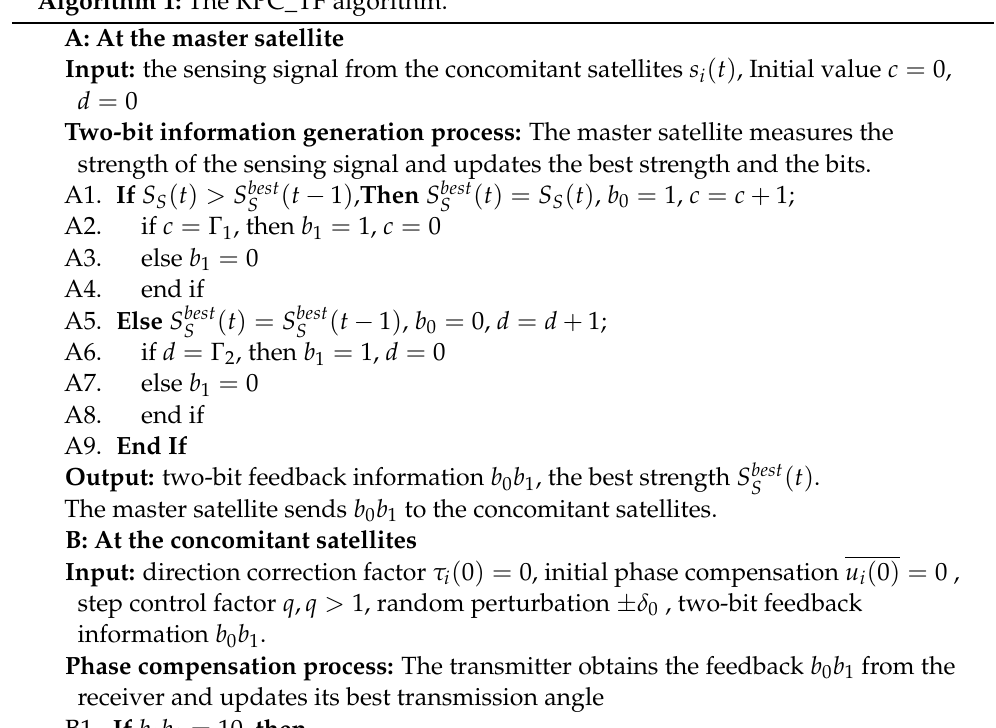
Algorithm 1: The RPC_TF